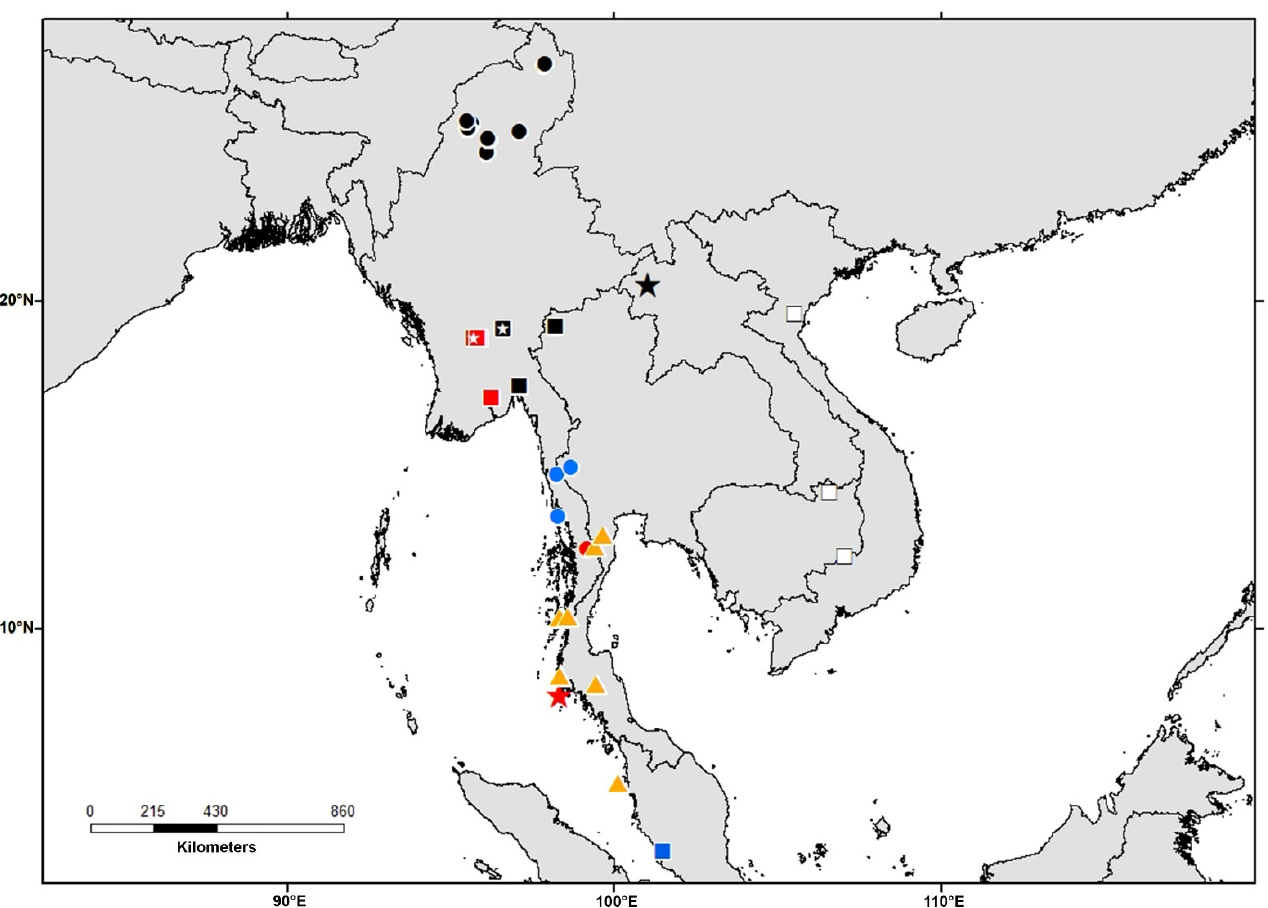
Figure 6. Map showing collecting localities of the Limnonectes species related to L. limborgi . Each symbol can represent one or more adjacent localities. Orange triangles = L. hascheanus ; blue square = L. limborgi Clade 1; red circle = L. limborgi Clade 2; black circles = L. limborgi Clade 3; black star = L. limborgi Clade 4; blue circles = L. limborgi Clade 5; red squares = L. limborgi Clade 6; black squares = L. limborgi Clade 7; white squares = L. limborgi Clade 8; red star = L. limborgi Clade 9. Small white stars within symbols indicate localities from which bioacoustics data have been used in this study. Table 5. Selected bioacoustic parameters of the species related to Limnonectes limborgi. Range is followed by mean value and standard deviation in parentheses. Dom. Freq. = dominant frequency; Freg. =